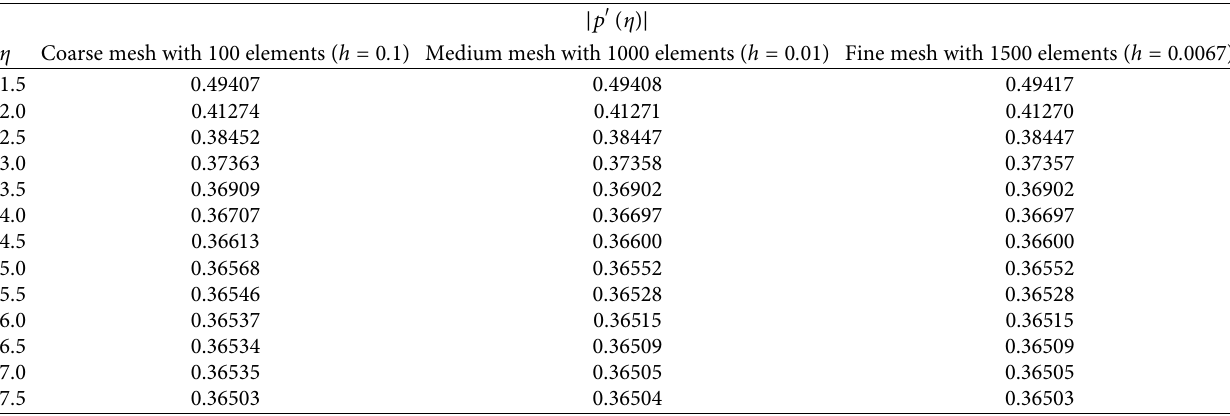
Table 2: Grid-independence test for angular velocity distribution.